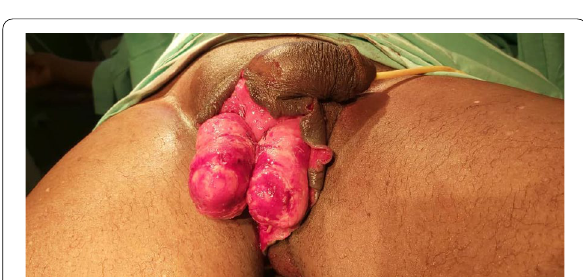
Fig. 2 The syndactilized testicles after